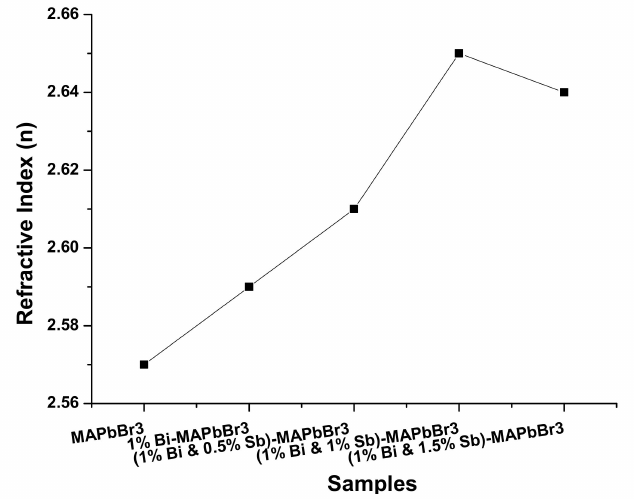
Figure 6. Refractive index pure MAPbBr 3 and 1% Bi and (0%, 0.5%, 1%, 1.5%) Sb co-doped MAPbBr 3